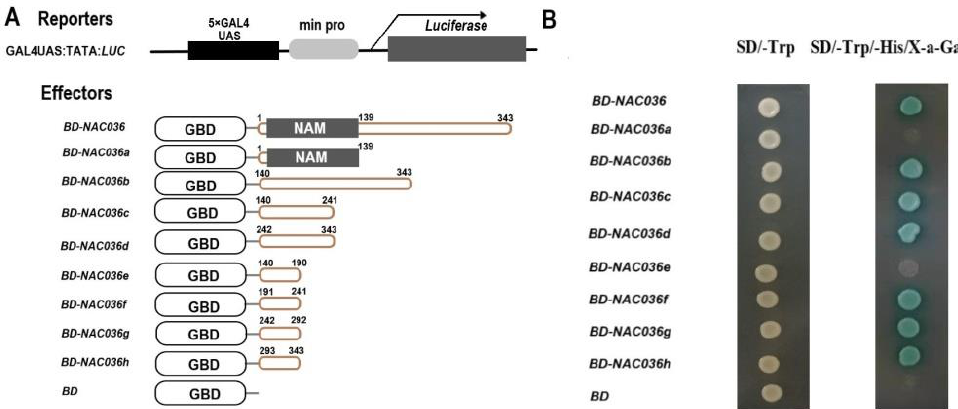
Figure 5. Transactivation analysis of PsnNAC036 protein. Transactivation analysis of PsnNAC036 protein. ( A ) Schematic diagrams of the effector and reporter constructs. The reporter construct includes GAL4 binding sites UAS and minimal CaMV35S promoter (min pro) upstream from the luciferase reporter gene. The effector constructs including BD-NAC036 and GAL4-BD were fused with full-length PsnNAC036 ; BD-NAC036a , N-terminal domain (1–139 aa); BD-NAC036b , C-terminal domain (140–343 aa); BD-NAC036c , half of BD-NAC036b (140–241 aa); BD-NAC036d , 242–343 aa; BD-NAC036e , half of BD-NAC036c (140–190 aa); BD-NAC036f , 191–241 aa; BD-NAC036g , half of BD-NAC036d (242–292 aa); and BD-NAC036h